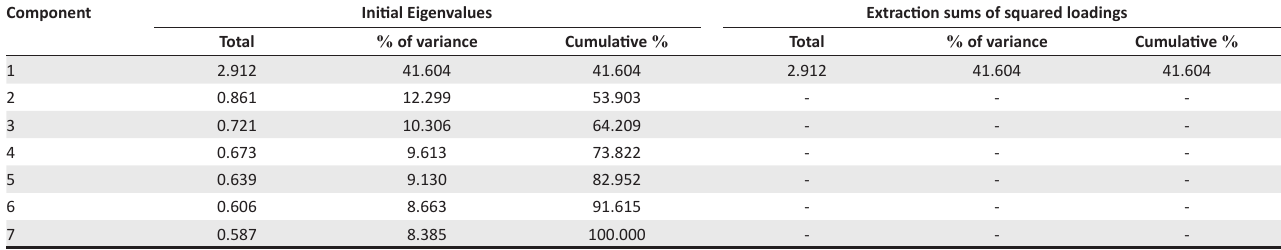
TABLE 2-A1: Principal component analysis: total variance explained for the items in the index sense of school belonging. Component Initial